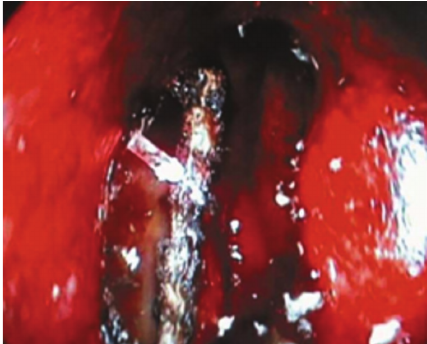
Figure 2: The ostium was expanded sufficiently with the fiber